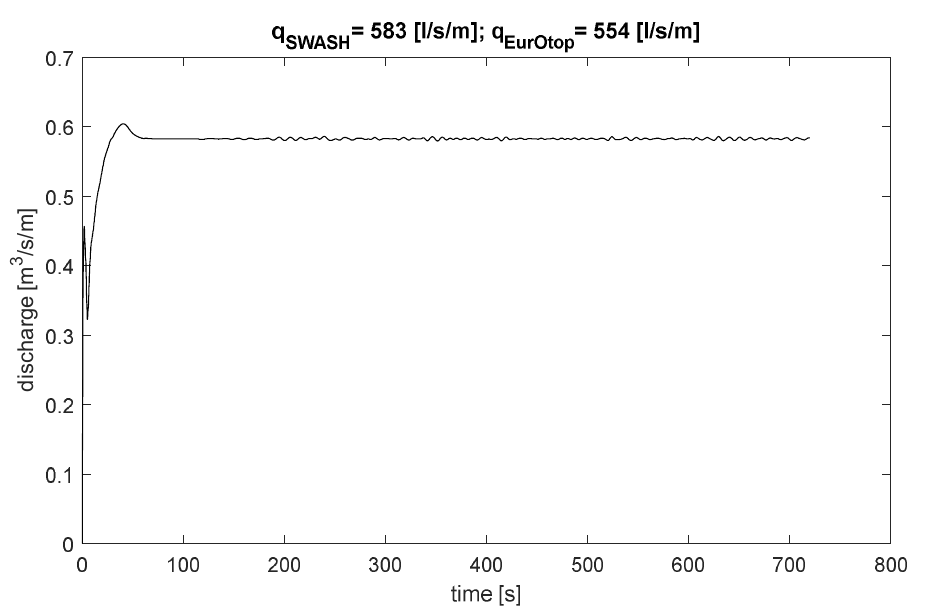
Figure 9. Time series of water surface elevation at offshore wave gauge WG1 and nearshore wave gauge WG2 ( upper ) and measured overflow discharge on the crest of the dike.